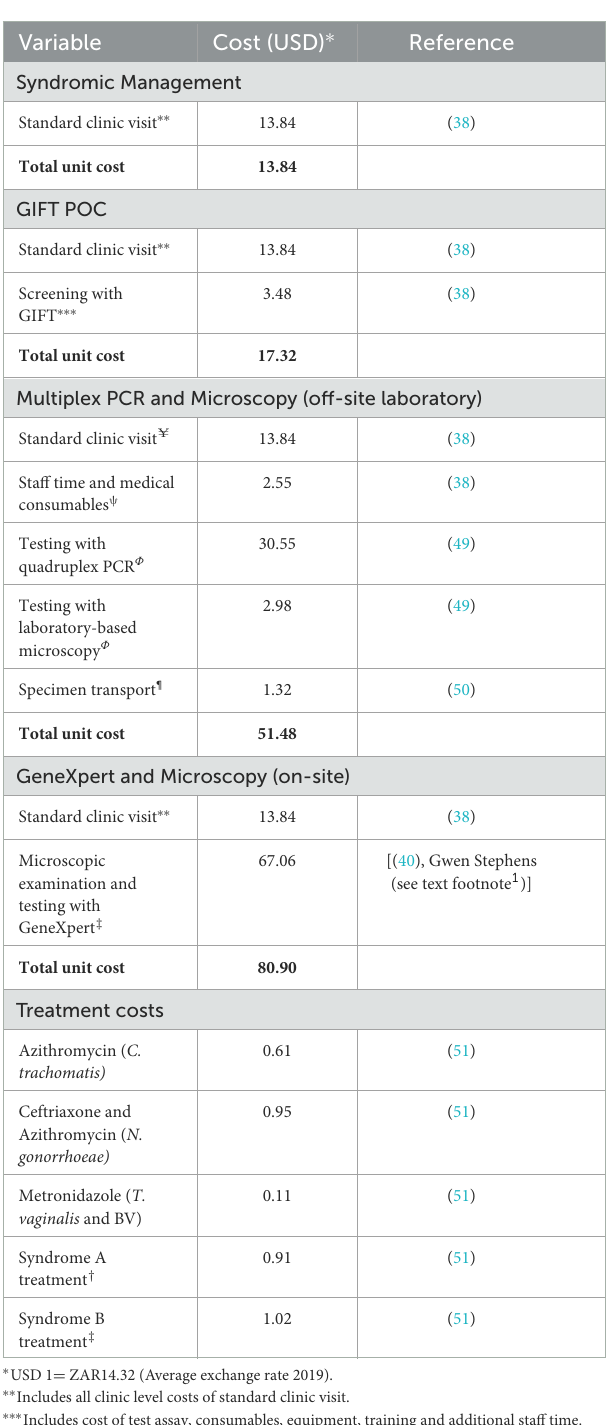
TABLE 3 Cost of screening or diagnosis and treatment per patient in 2019